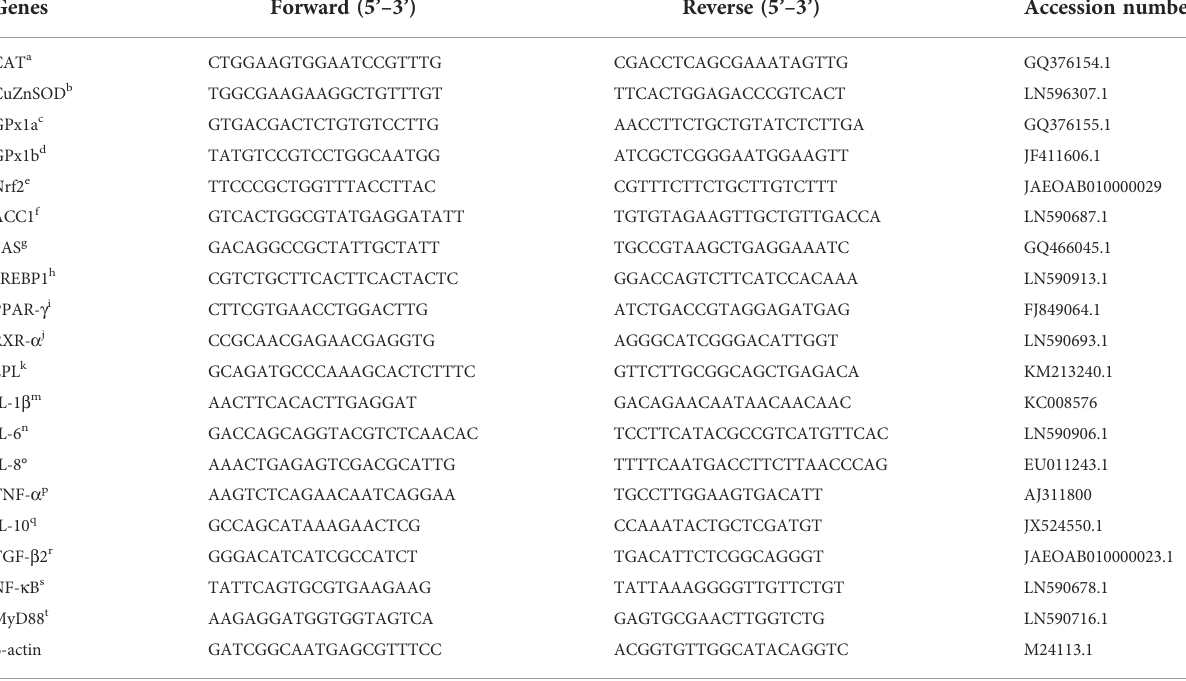
TABLE 2 Primer sequences for quantitative real-time